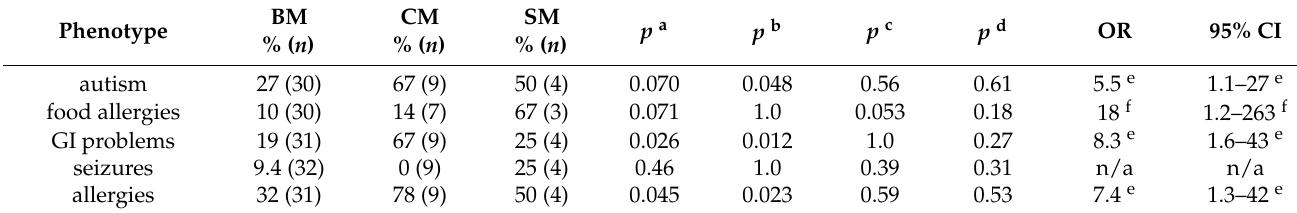
Table 9. Analysis of FXS comorbidities as a function of exclusive milk use in males.